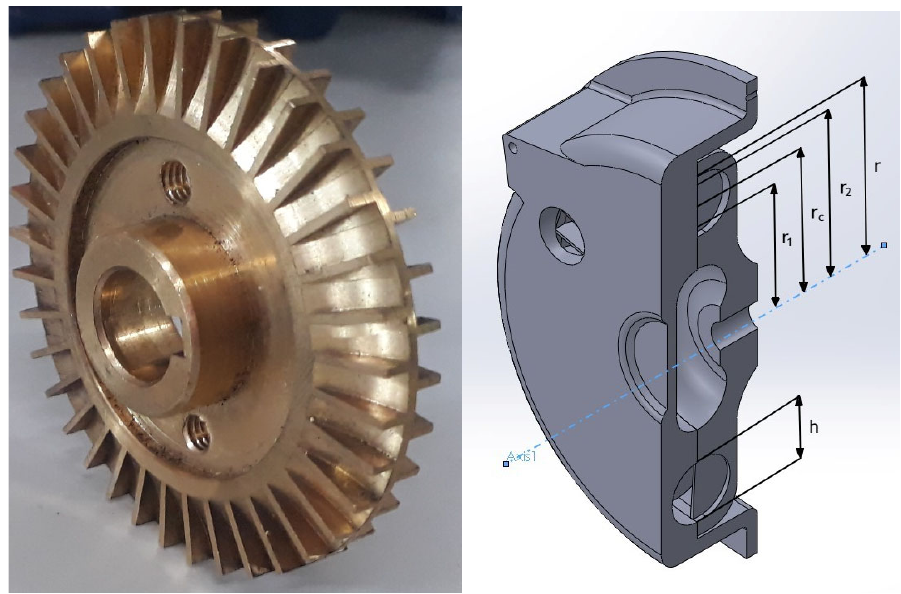
Figure 1. Image of a double ‐ side vane impeller and some important dimensions. Impeller Diameter ( d )